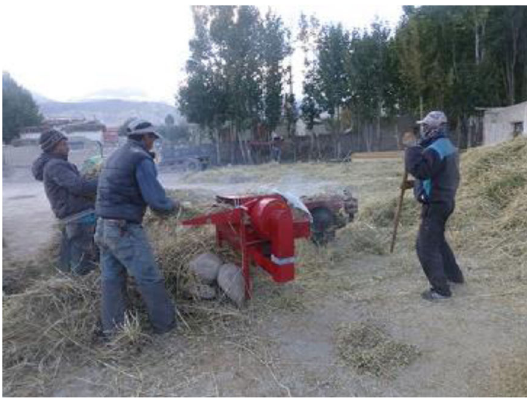
Fig. 14 Green house as technological adaptation used for vegetable farming and growing